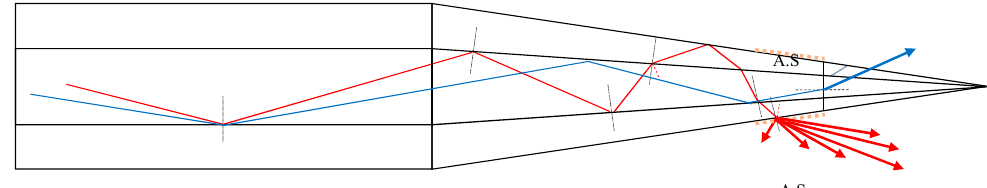
Figure 12. Schematic ray optic diagram of fiber taper cutback and optical diffusion from the side of the AS.